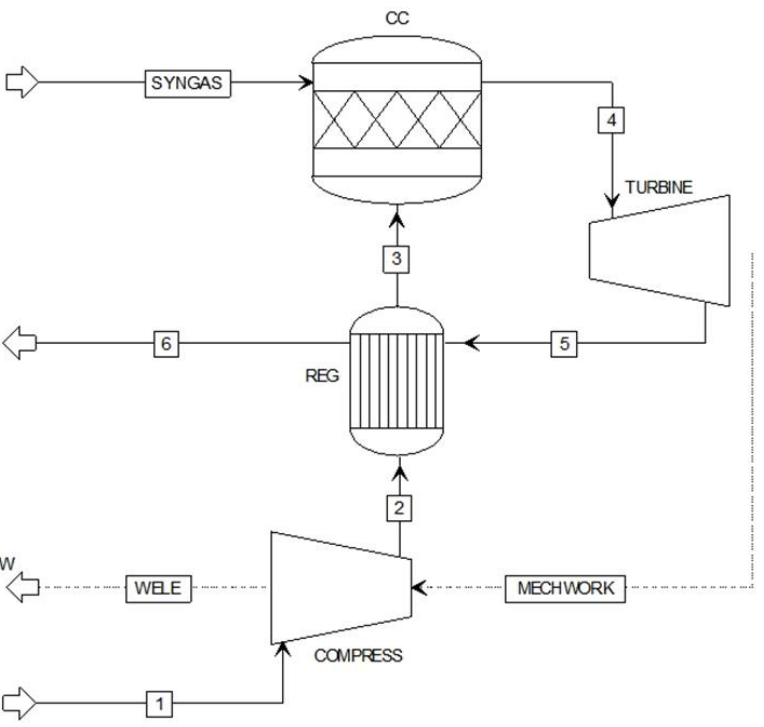
Figure 3. Gas microturbine scheme.